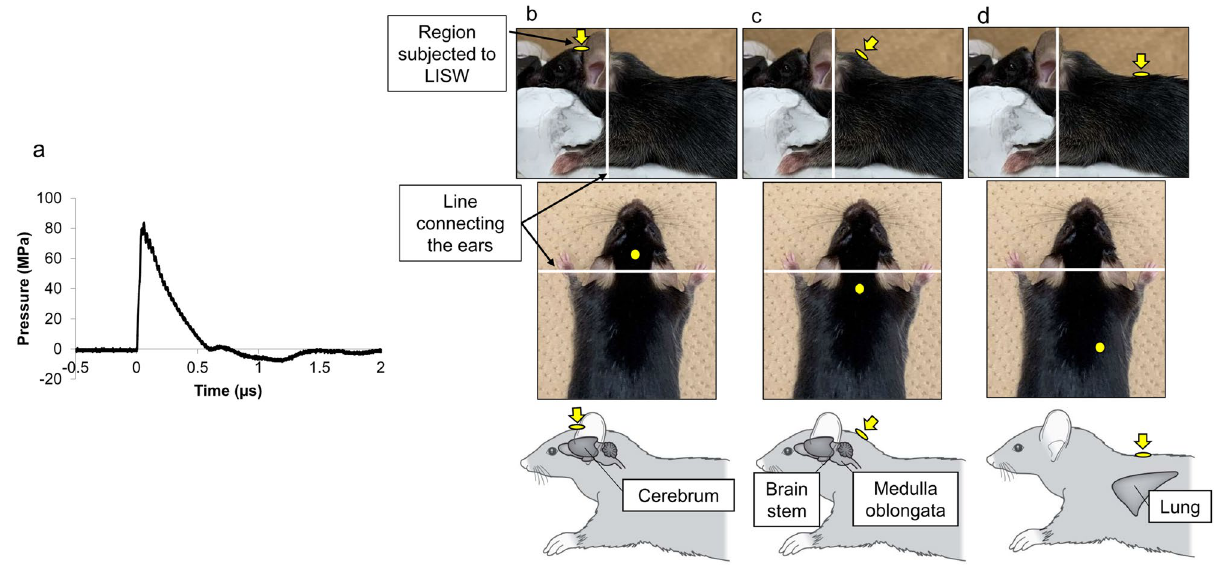
Figure 1. Laser-induced shock wave (LISW) method. ( a ) Typical time–pressure waveform for LISWs with a laser fluence of 3.0 J/cm 2 : Peak pressure, 81.8 MPa; impulse, 19.9 Pa·s; duration, 0.58 μs. ( b – d ) Regions subjected to LISWs. ( b ) Frontal region (cerebrum as the target: 5-mm cephalad of the line connecting the ears). ( c ) Upper neck region (brainstem as the target: 5-mm caudal to the line connecting the ears). ( d ) Right thoracic dorsum (right lung as the target: 20-mm caudal to the midline and 5 mm to the right of the the line connecting the